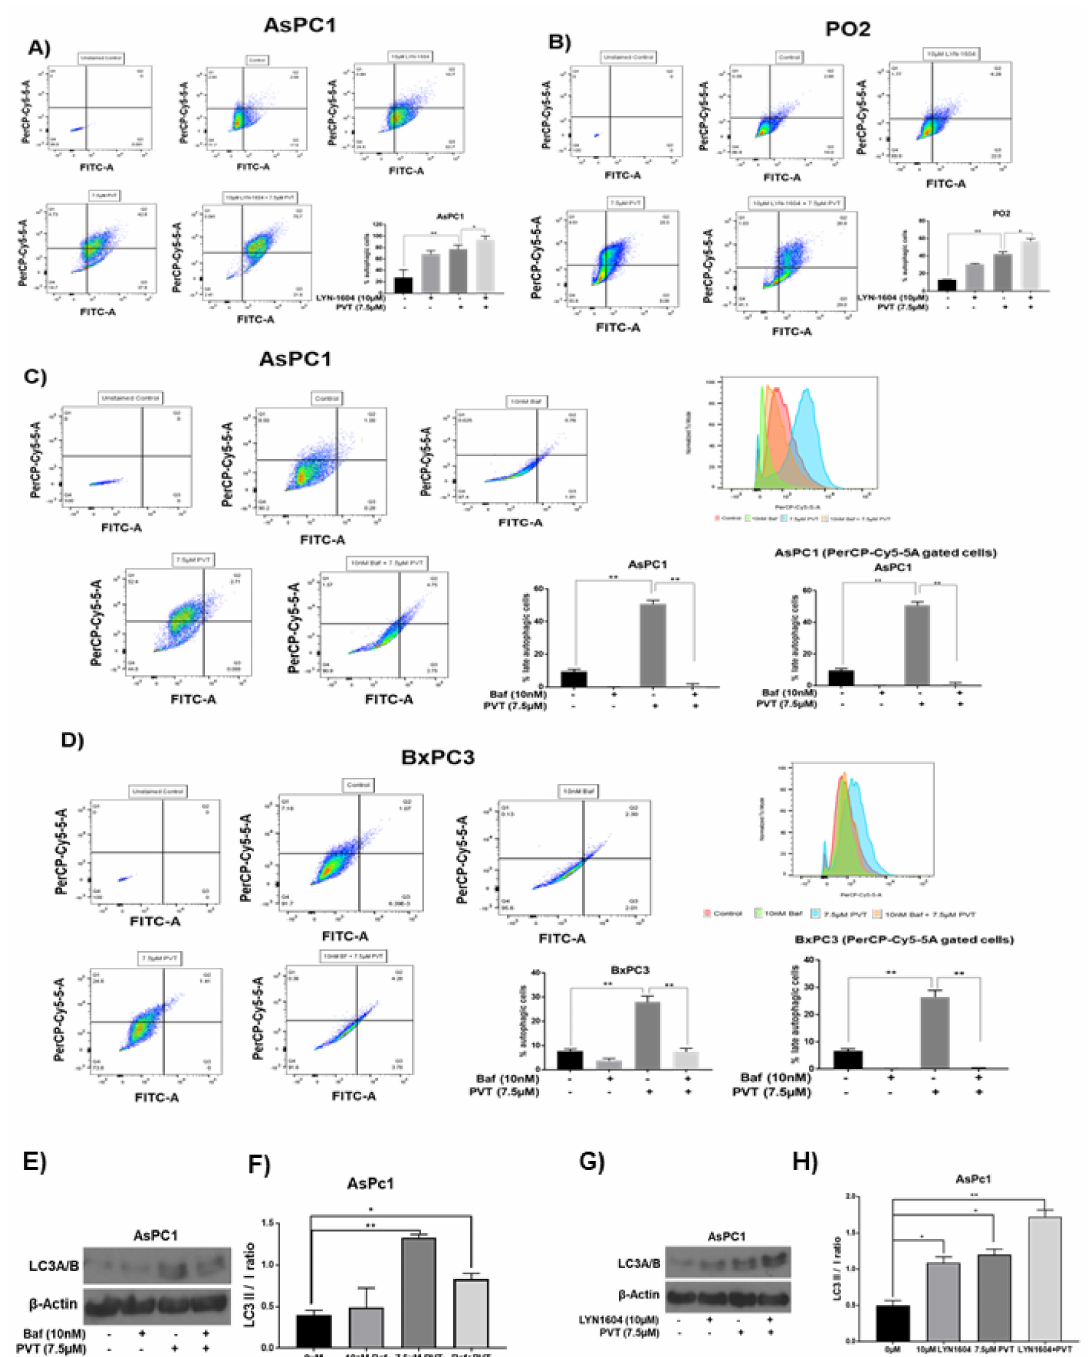
Figure 6. ULK1 agonist LYN-1604 potentiates autophagic effects of PVT in ( A ) AsPC1 and ( B ) PO2 PDAC cells pretreated with 10 µ M LYN-1604 for 3 h and then treated with 7.5 µ M PVT for 24 h. Blocking autophagy using Bafilomycin suppressed autophagy inducing effects of PVT in ( C ) AsPC1 ( D ) BxPC3 PDAC cells pretreated with 10 nM bafilomycin (Baf) for 3 h and then treated with 7.5 µ M PVT for 24 h. Single cell suspension was then analyzed by acridine orange assay using flow-cytometry. ( E ) Western blot analysis of LC3A/B on AsPC1 cells pretreated with 10 nM bafilomycin (Baf) for 3 h and then treated with 7.5 µ M PVT for 24 h ( F ) LC3 II/I ratio from Figure 6E. ( G ) Western blot analysis of LC3A/B on AsPC1 cells pretreated with 10 µ M LYN-1604 for 3 h and then treated with 7.5 µ M PVT for 24 h. ( H ) LC3 II/I ratio from Figure 6G. * p ≤ 0.05, ** p ≤